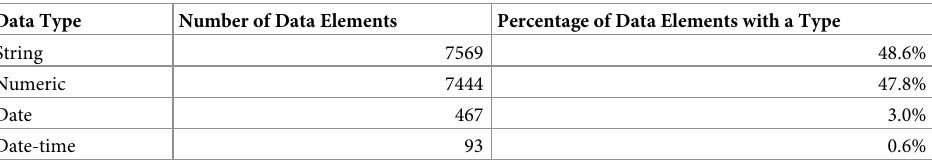
Table 5. Count and percentage of data elements by data